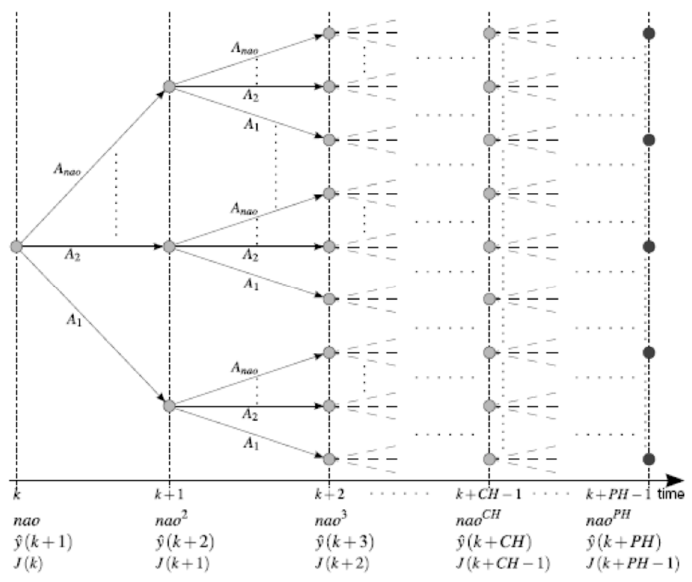
Figure 11. Branch-and-bound tree structure for model-based predictive control [41].